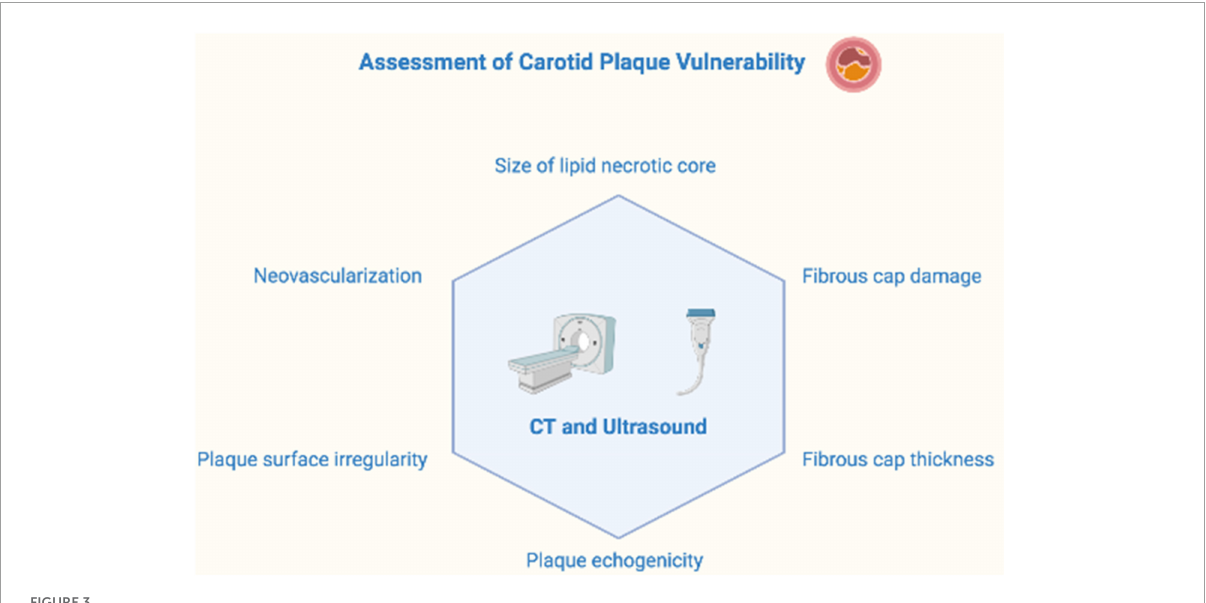
FIGURE3 Features assessed in the qualitative analysis of plaque